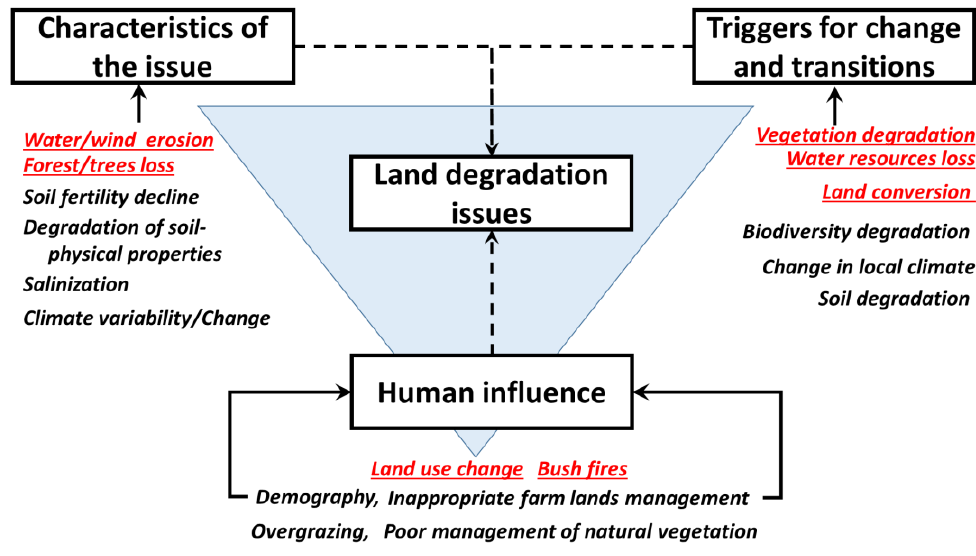
Figure 2. Land degradation linkages ( * red underlined text indicate the factors that can be monitored using remote sensing